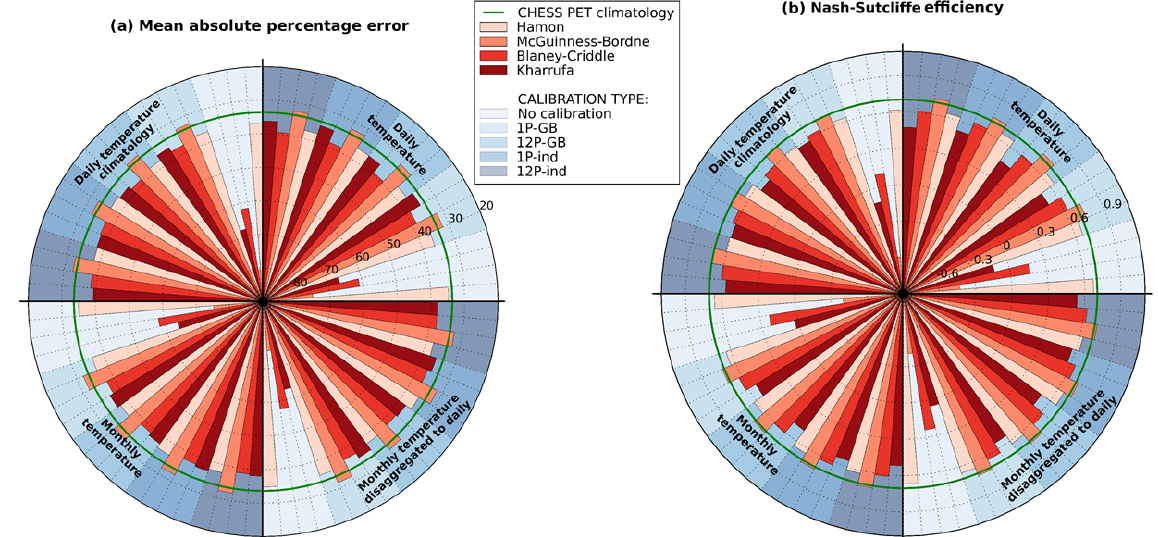
Figure 4. Performance of the different combinations of PET equations (shown in different shades of red), calibration approaches (shown in different shades of blue) and input temperature data (one in each quadrant). The green line on the plots shows the reference CHESS PET climatology for comparison. (a) Mean absolute percentage error (MAPE) – note that the y axis is inverted so that lower MAPE values (which indicate better performance) are shown towards the outside of the radial plot. (b) Nash–Sutcliffe efficiency (NSE); a higher NSE indicates better